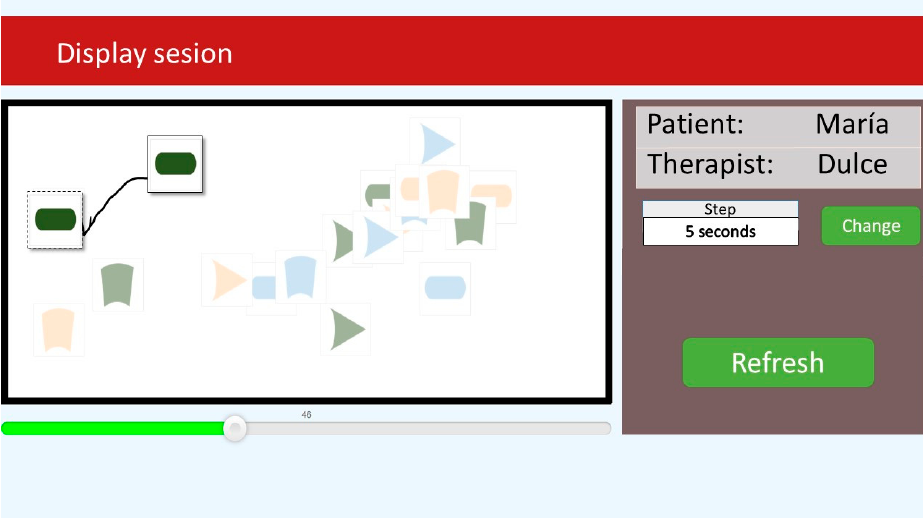
Figure 2. Assessment session summary information.